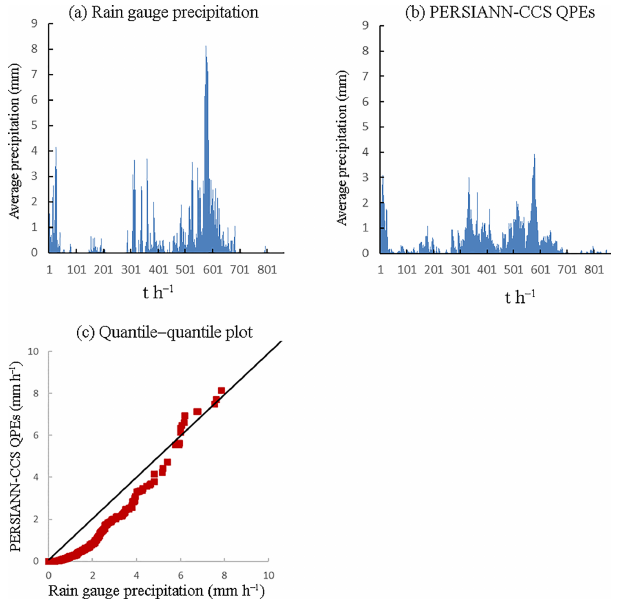
Figure 5. Precipitation pattern comparison of two precipitation products (2009): (a) is the average precipitation of rain gauges, (b) is the average precipitation of PERSIANN-CCS QPEs, and (c) is the quantile–quantile plot, in which the 45 ◦ line is used to compare the two precipitation products.